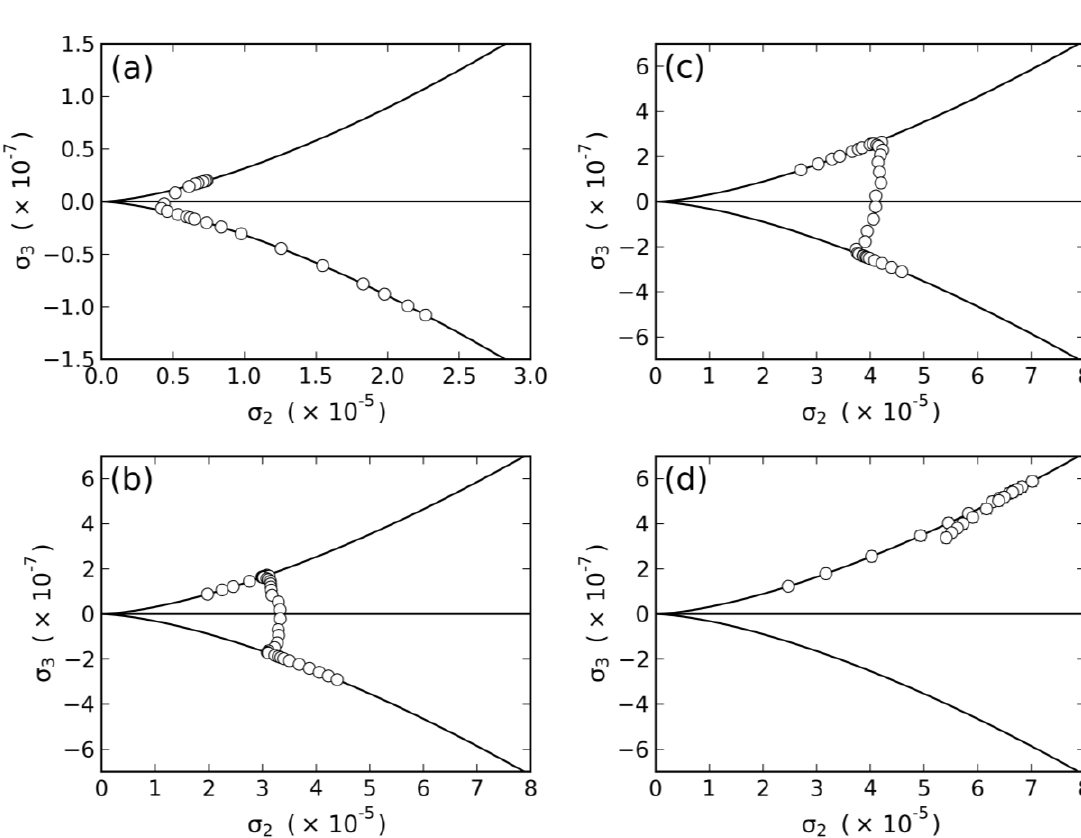
and σ , of the 2 3 SO /UndeOH/water; 2 4